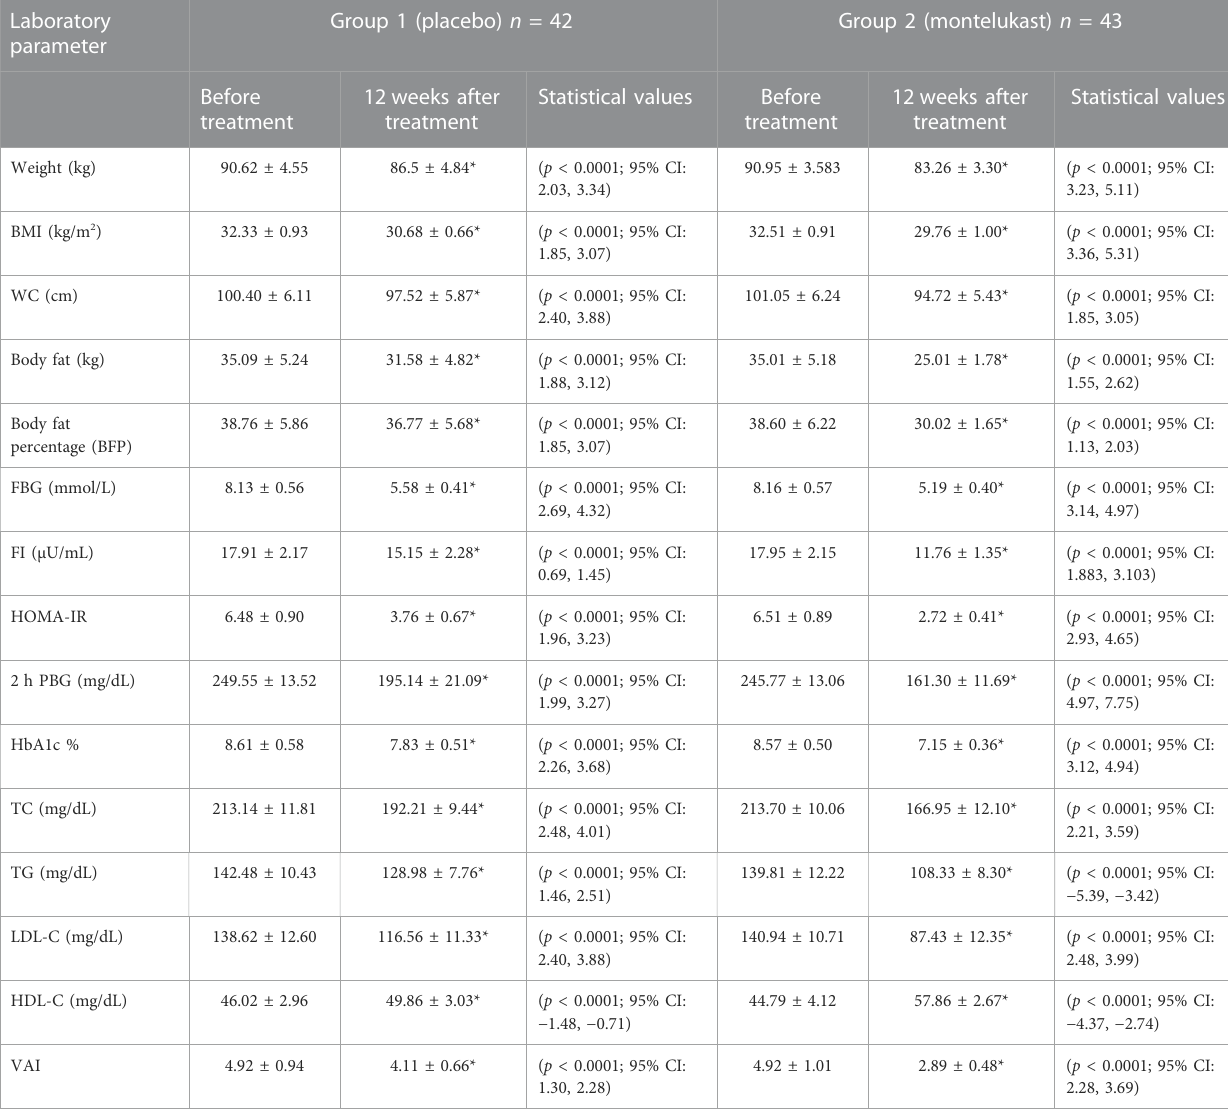
TABLE 2 Anthropometric and laboratory data on the two study groups before and after treatment. Laboratory